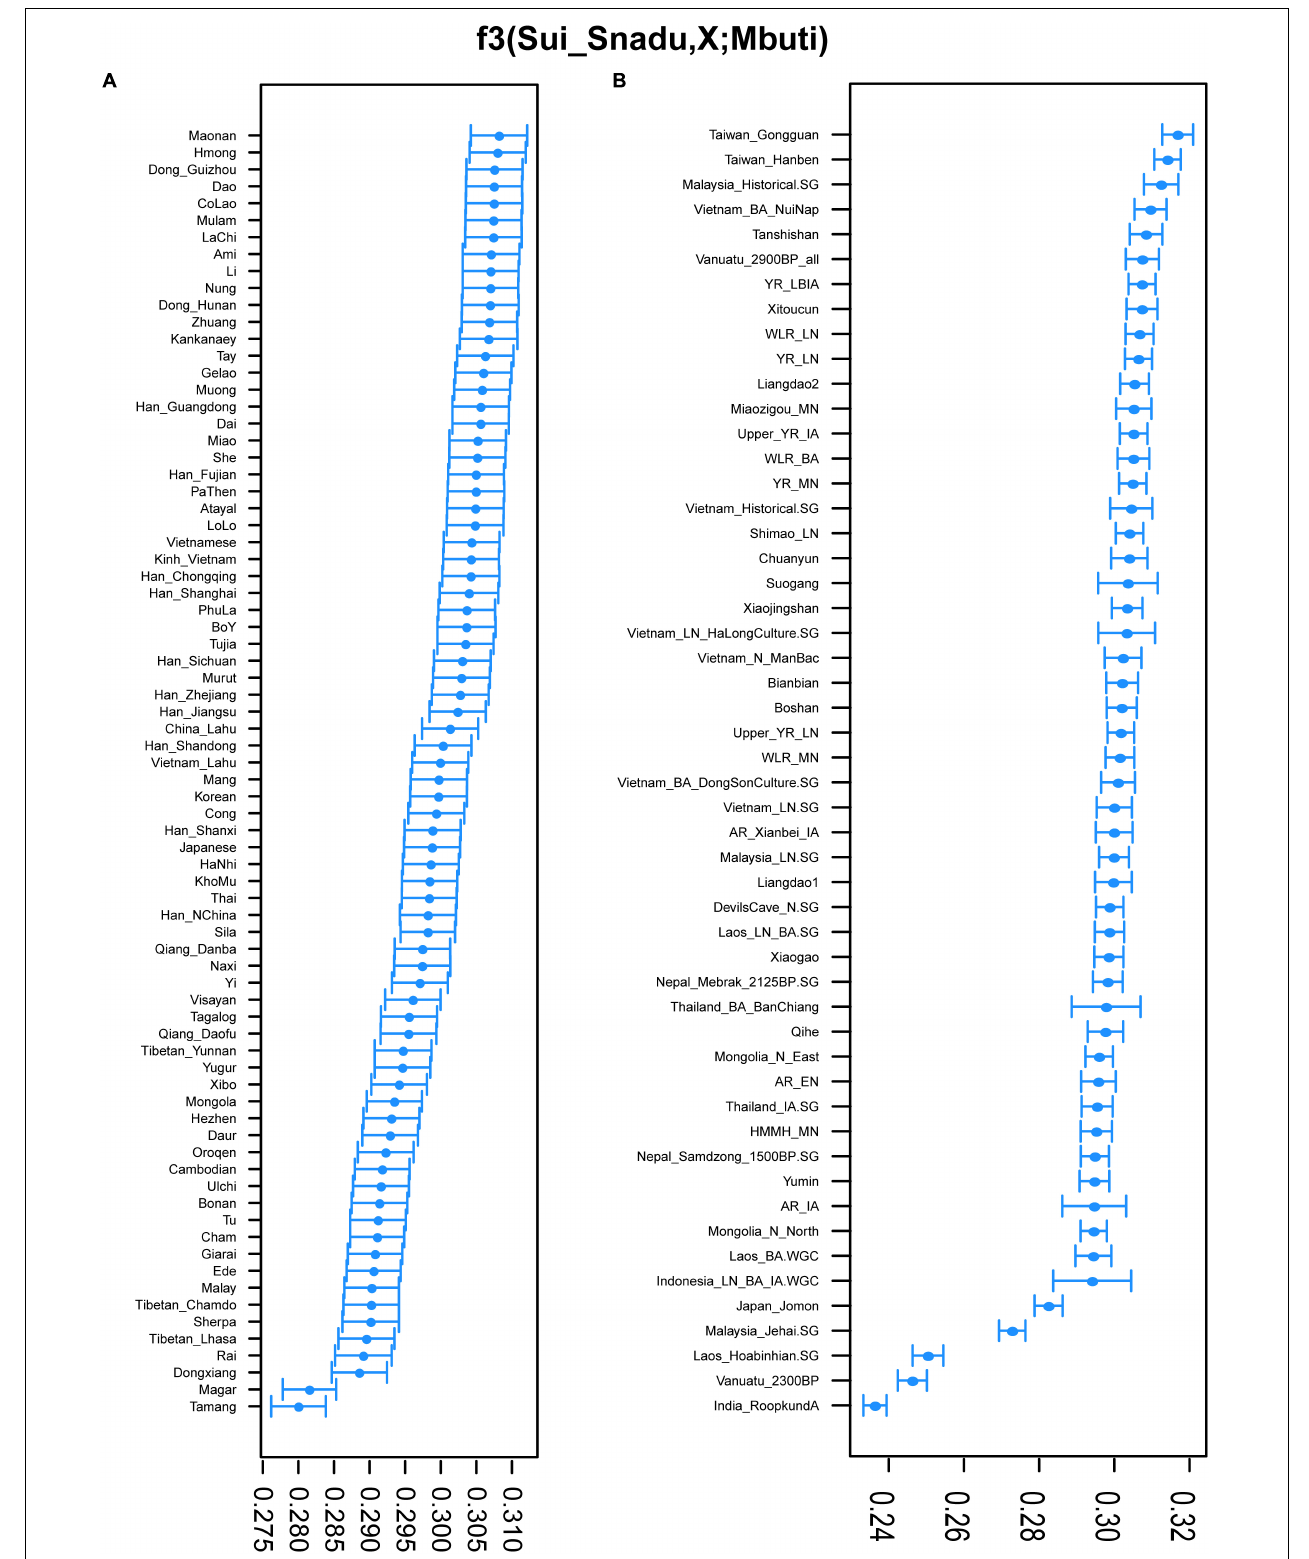
FIGURE 4 | The shared genetic drift between Sui and modern/ancient populations in Asia showed a closer affinity of Sui and Tai-Kadai/Hmong-Mien populations.